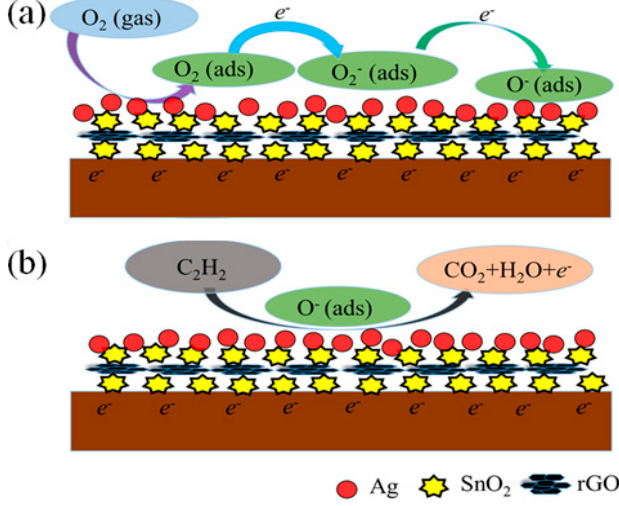
Figure 11. The sensing mechanism of the Ag–SnO 2 /rGO nanocomposite film in ( a ) air and ( b ) acetylene gas. ( b ) acetylene